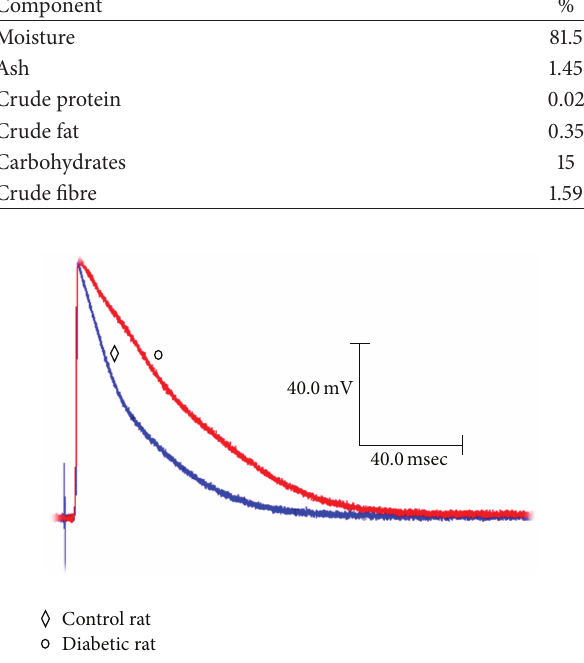
Figure 1: Changes in the action potential with diabetes. Represen- tative action potentials obtained from a cell of the papillary muscle of the left ventricle of the heart of control rats and diabetic rats at a basic cycle of 500